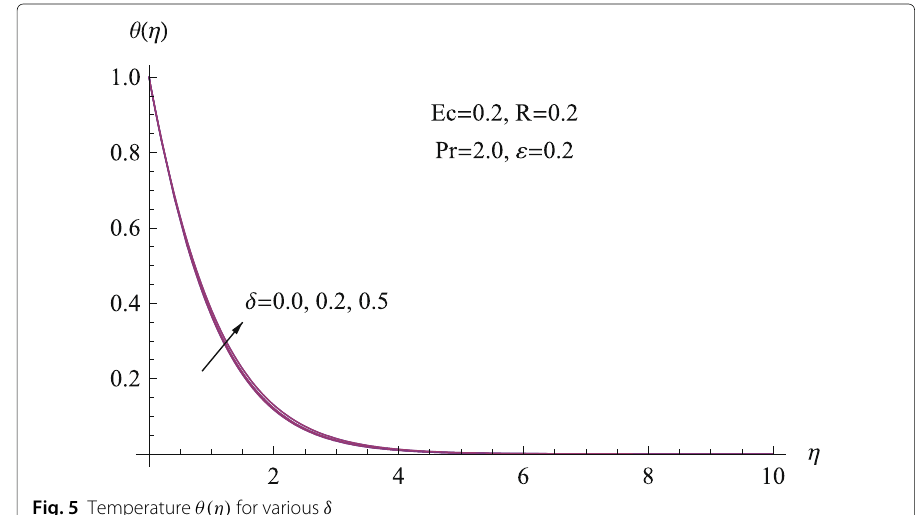
Fig. 5 Temperature θ(η) for various δ